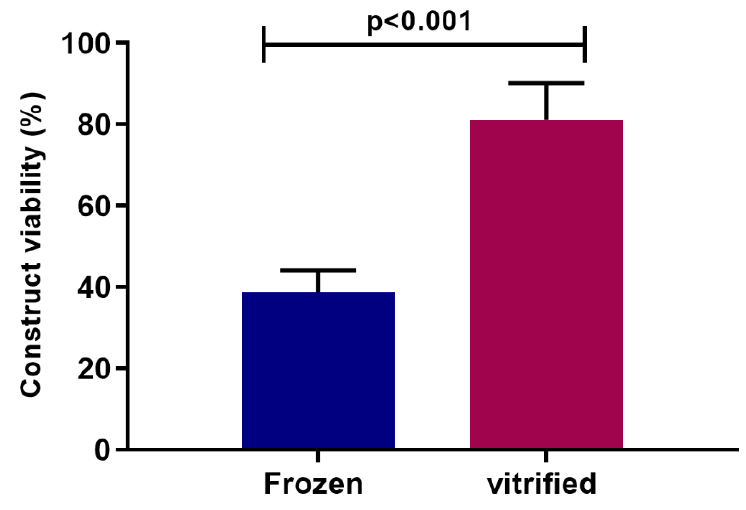
Figure 1. Viability of EpiDerm constructs after freezing and vitrification. Constructs were either cryopreserved by freezing in 15% glycerol/10% hydroxyethyl starch (HES) or vitrified in VS55. Viability was calculated as the mean ( ± SEM) of 9–12 replicates. Statistical comparison performed by T test.